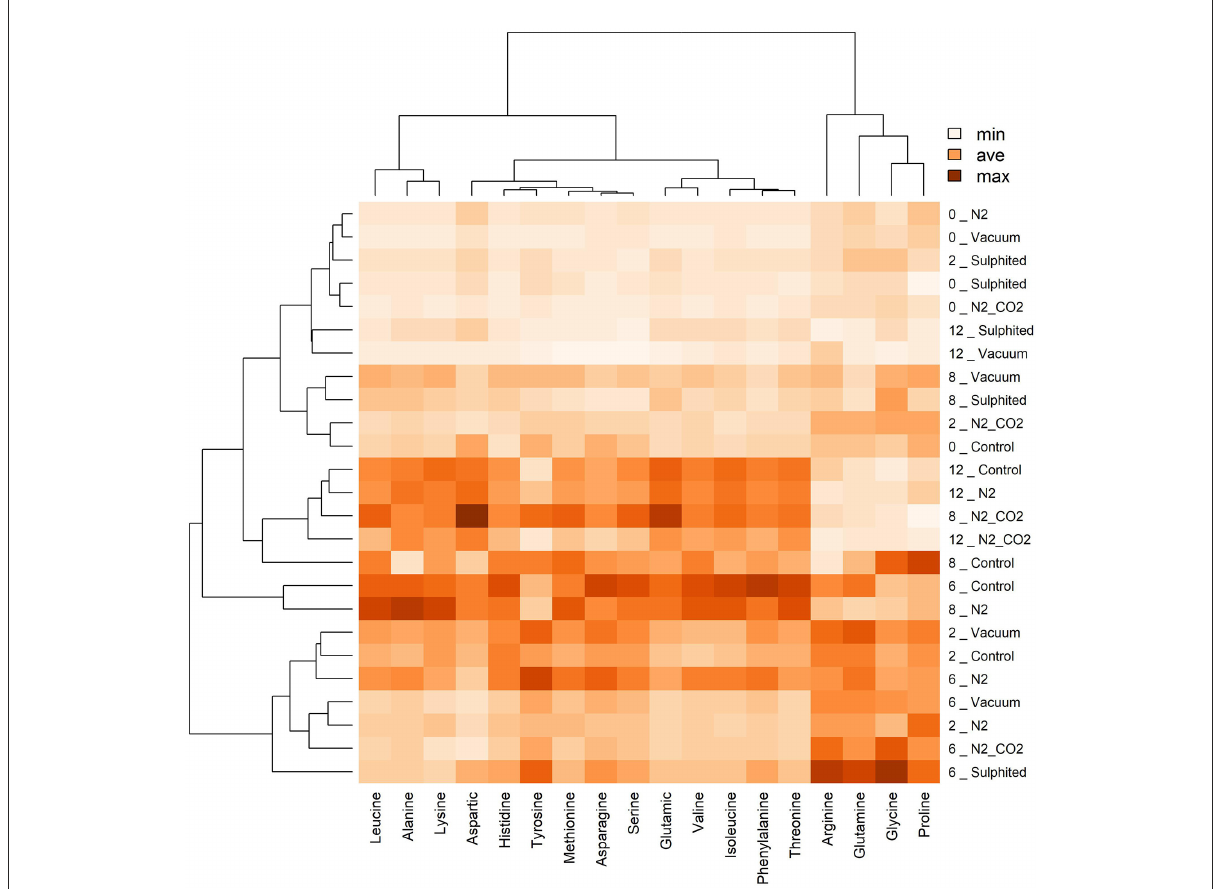
FIGURE7 Heat map visualization and clustering results of FAAs in deep water rose shrimps during frozen storage, regardless of the effects packaging method (y-axis). Similar to Figure 6, the heat map was generated using hierarchical clustering analysis to identify the color intensity of each FAA (minimum intensity, no color; average intensity, yellow; maximum intensity, brown). Values adjacent to packaging methods represent frozen storage time in